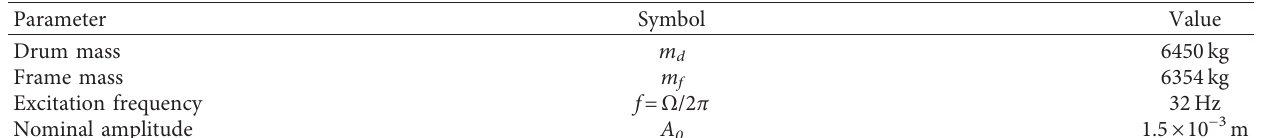
Figure 1: The drum-subgrade coupling dynamic model. Table 1: Compaction model parameters.